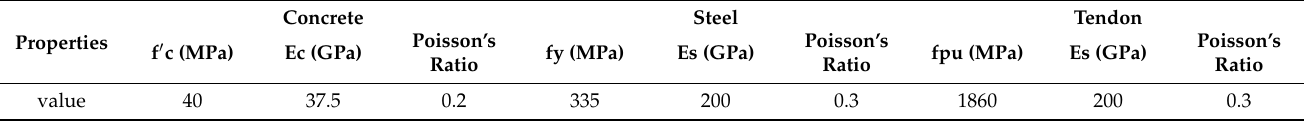
Figure 3. Specimen data. Table 1. Properties of all tested beam specimens.